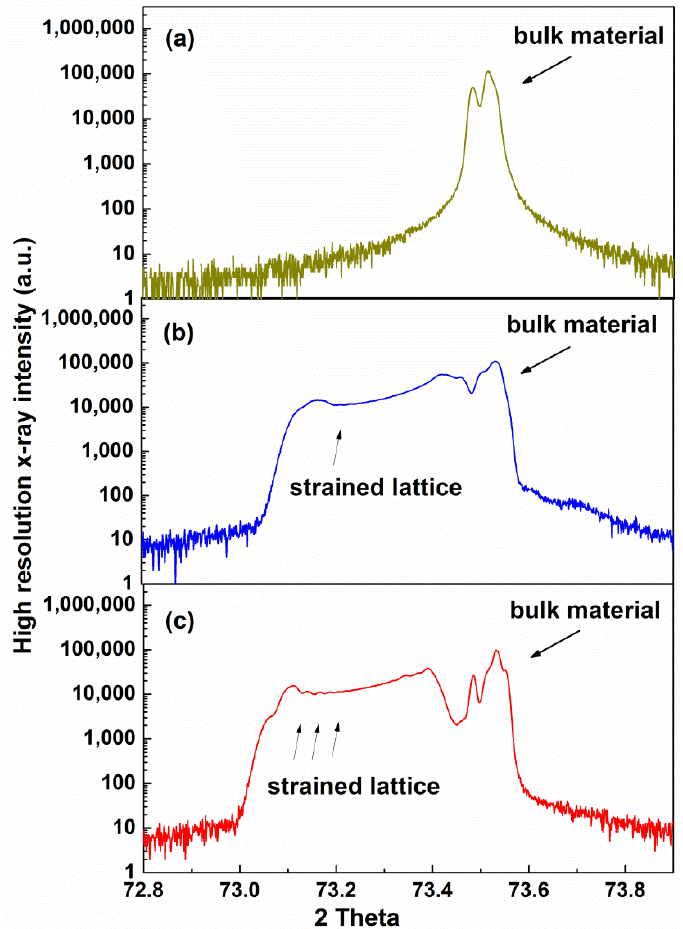
Figure 4. High-resolution X-ray diffraction curves of ( a ) pristine crystal, ( b ) crystal irradiated with fluence of 5 × 10 14 ions/cm 2 , ( c ) crystal with fluence of 1.5 × 10 15 ions/cm 2 .